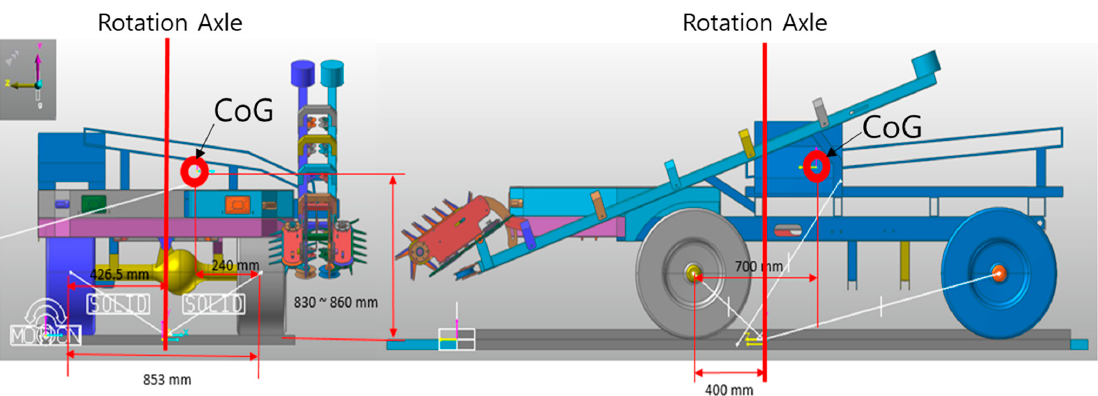
Figure 6. The rotational axle of the self-propelled radish harvester for adjusting the deflection an-